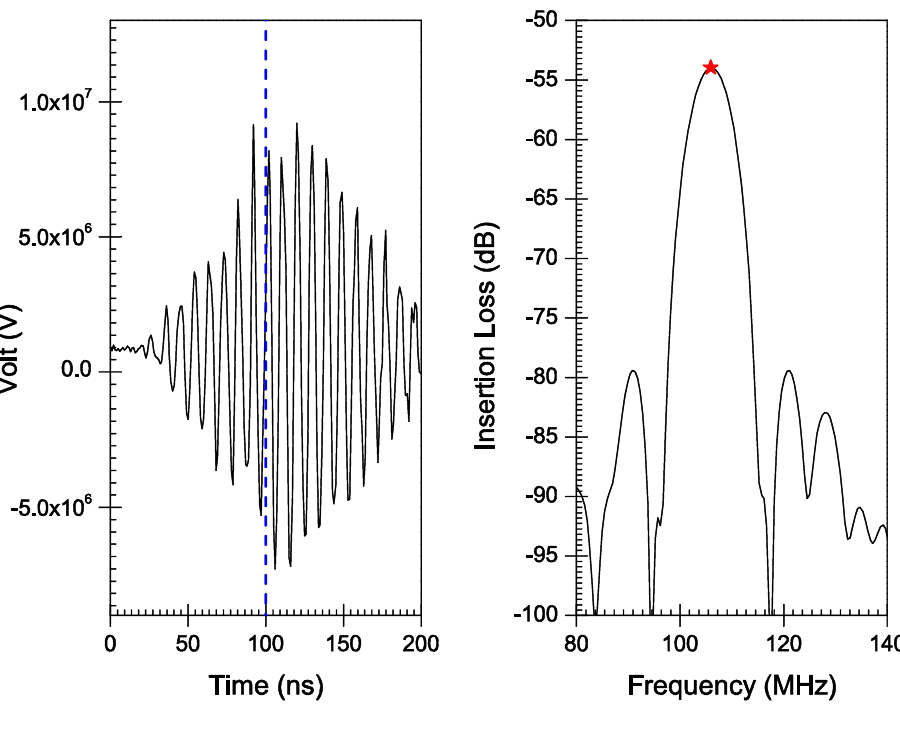
Figure 8. Time and frequency response for h /λ = 0.14.